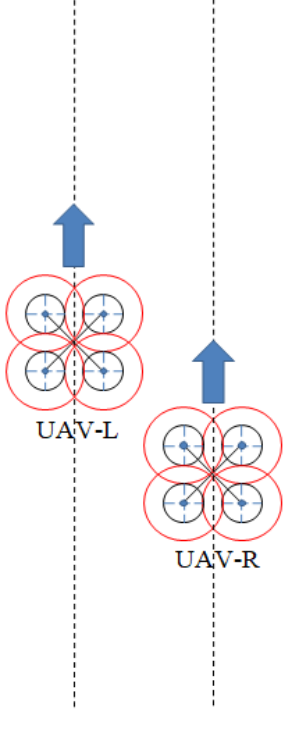
Figure 2. Simultaneous spraying.